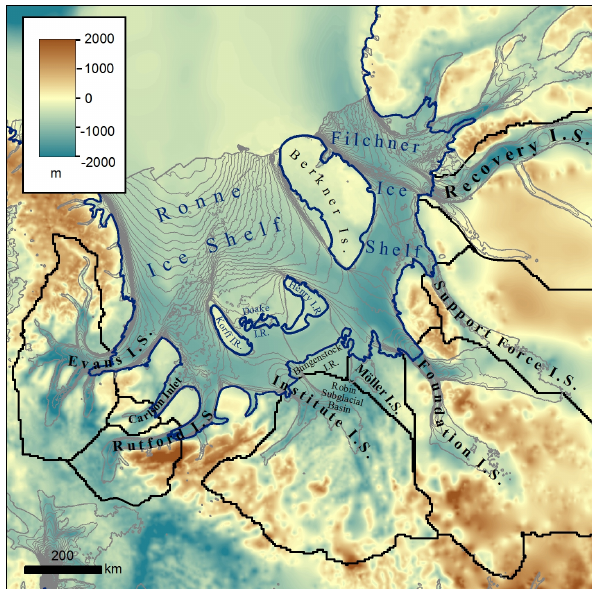
Figure 1. Catchments of the Filchner–Ronne Ice Shelf tributaries, shown overlain on the Bedmap2 bed topography (colour scale) used in this study. Ice velocity from Rignot et al. (2011) is indicated by grey contours at 50ma − 1